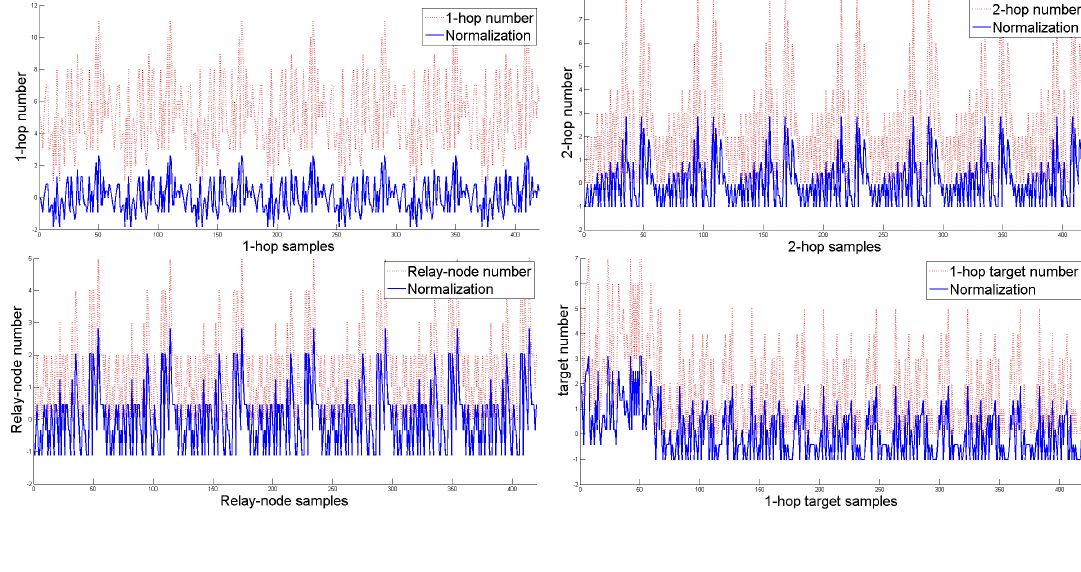
Figure 12. The preprocessing results of the network inputs and targets.